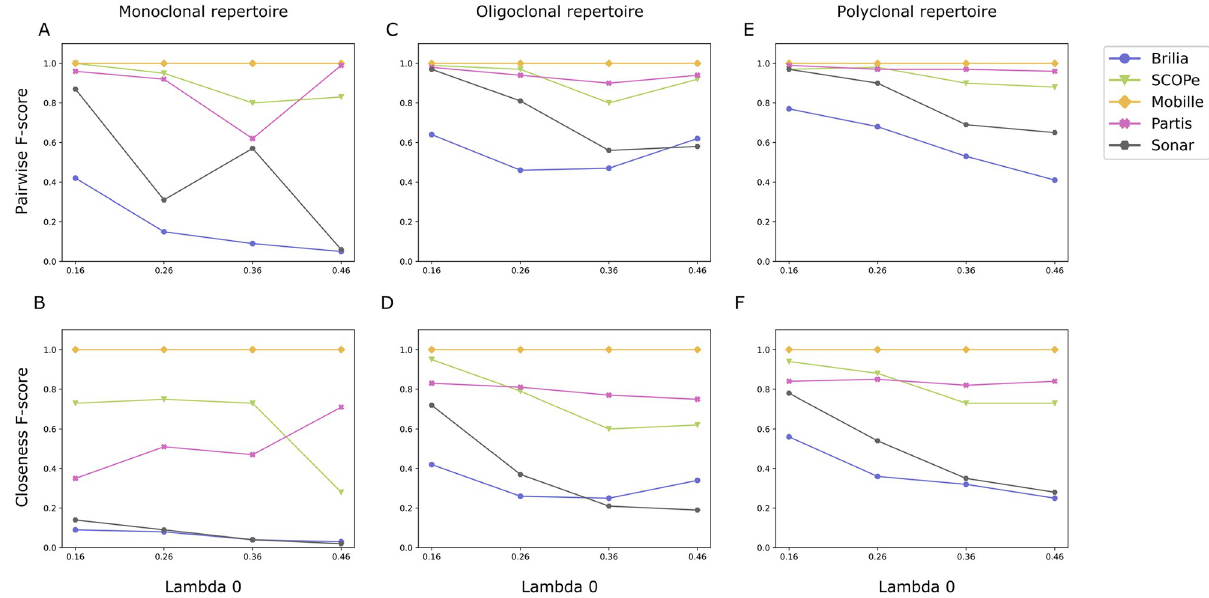
Fig 7. Comparison of clustering accuracy on simulated repertoires. Performance evaluation of five different BCR lineage grouping methods on 12 simulated repertoires.